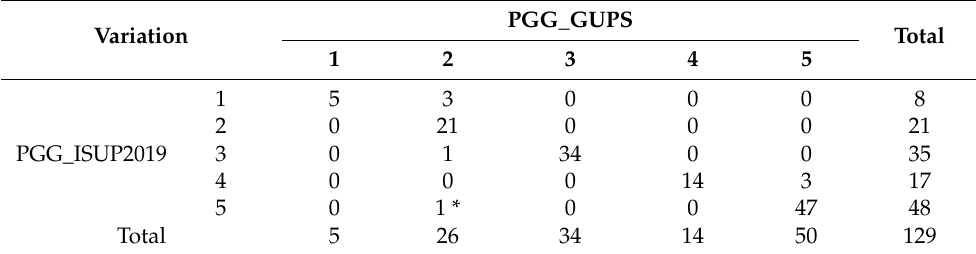
Table 3. Comparison between the two grading